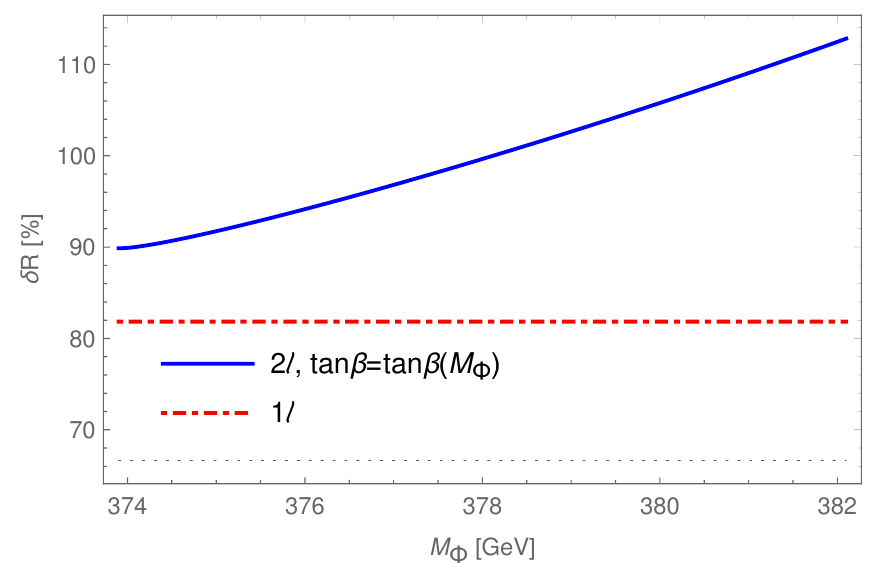
Figure 11 . BSM deviation δR — defined in eq. (3.12) — of the Higgs trilinear coupling ˆ λ hhh computed at two loops in the CSI-2HDM with respect to its SM prediction as a function of the degenerate mass of the BSM scalars M Φ = M H = M A = M . The value of tan β in the point H ± in this figure is computed as a function of M Φ using equation (4.21). Finally, the maximal value of M Φ (equivalently the maximal value of tan β ) in this plot is constrained by the requirement of tree-level perturbative unitarity — cf. figure 10. The red dot-dashed and black dotted lines show the comparison of the one-loop CSI value of λ hhh with respectively the one-loop effective-potential and tree-level results in the